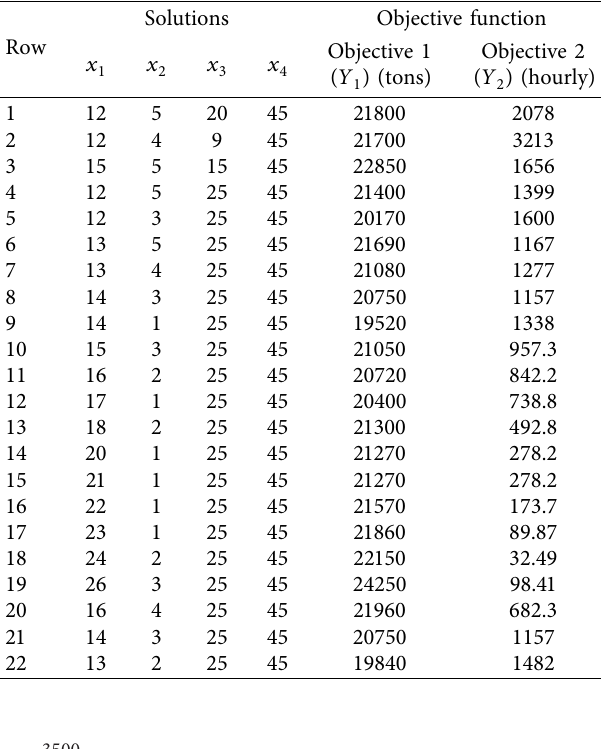
Table 9: Nondominated points obtained.